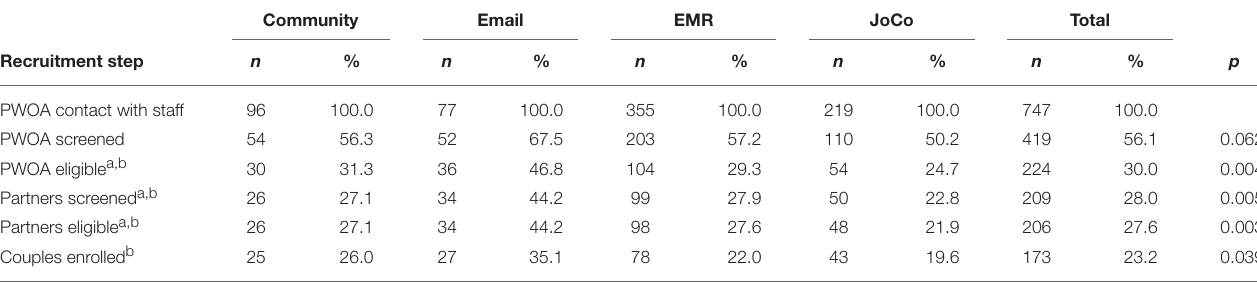
TABLE 1 | Number and proportion of couples that completed study recruitment steps in PALS by recruitment